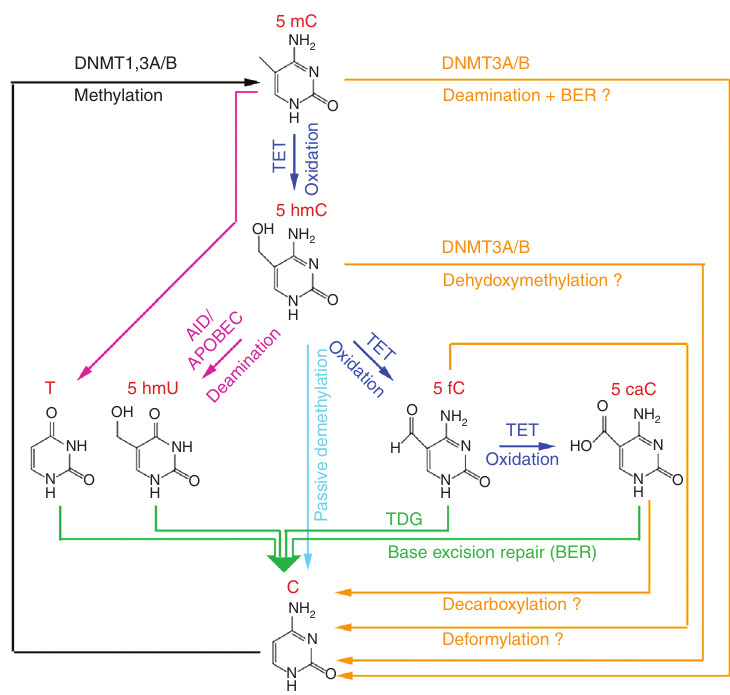
Figure 3 Scheme depicting enzymatic steps involved in the regulation of DNA methylation and demethylation through oxidation, deamina- tion, passive demethylation, and other putative